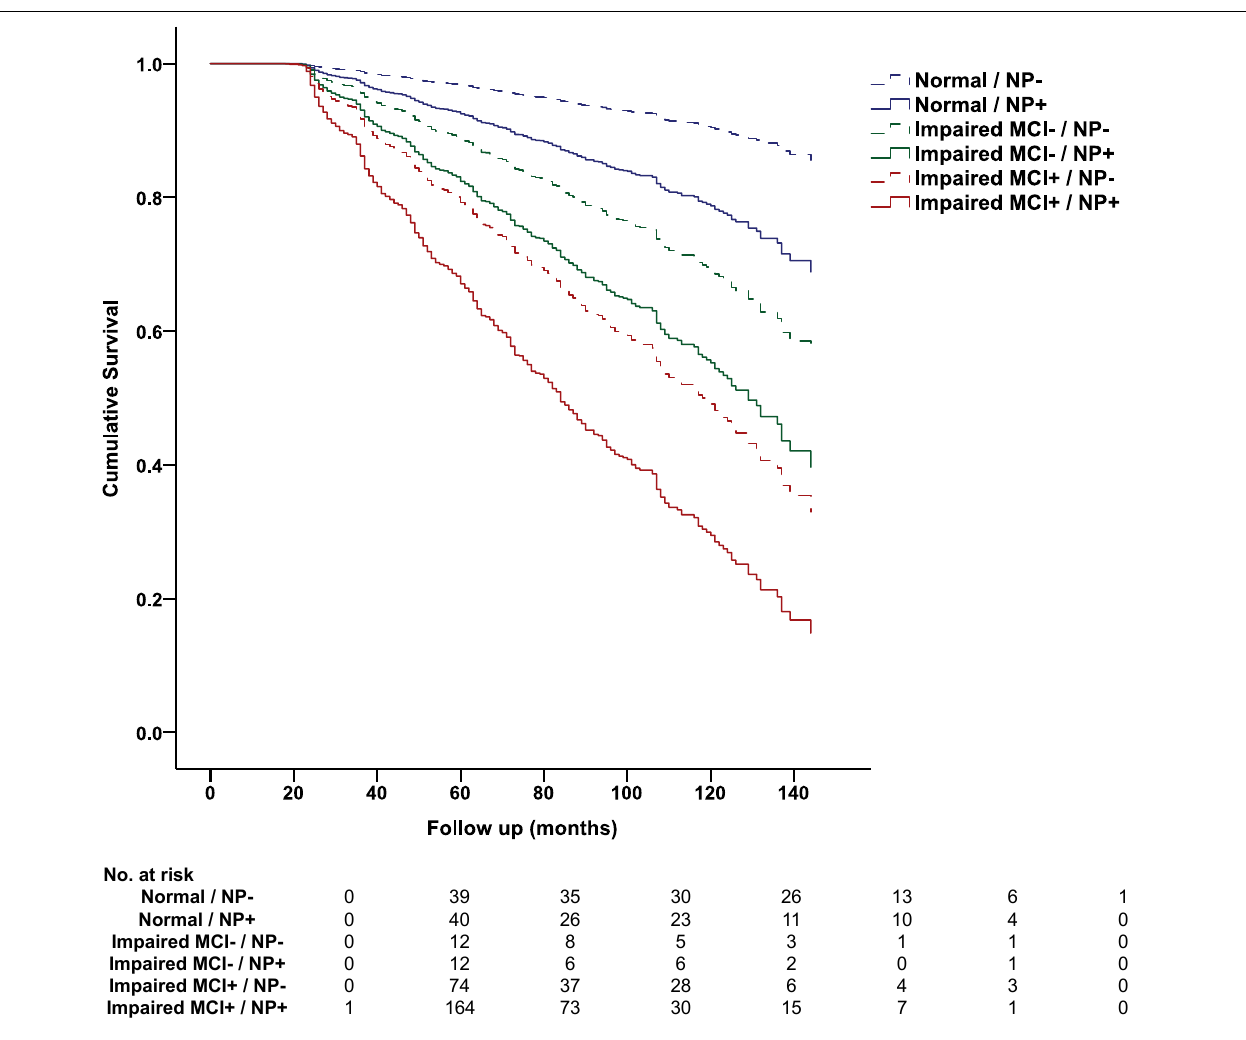
FIGURE 2 | Progression to dementia stratified by cognitive status and NP decline status in the National Alzheimer’s Coordinating Center Database. Cumulative progression to dementia from Cox regression analysis is displayed and stratified by baseline NACC diagnosis, including Normal Cognition (Normal), Impaired without MCI (Impaired MCI − ), Impaired with MCI (Impaired MCI + ), and NP decline status at 12-month follow-up based on optimal cutoff values, including NP decline absent (NP − , above 28th percentile) and NP decline present (NP + , at or below 28th percentile). The table below displays the number of participants who progressed to dementia at each follow-up